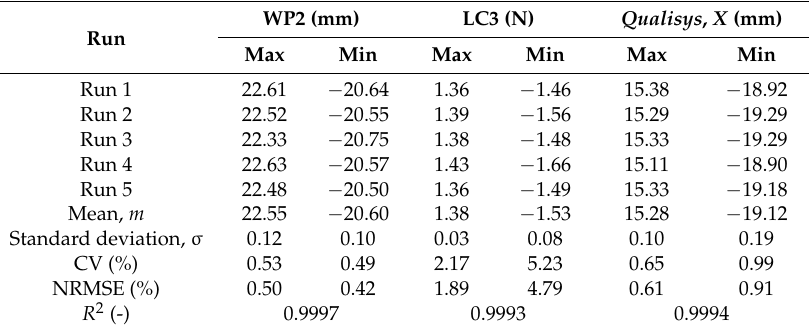
Table 8. Results of repeatability analysis for wave only runs.